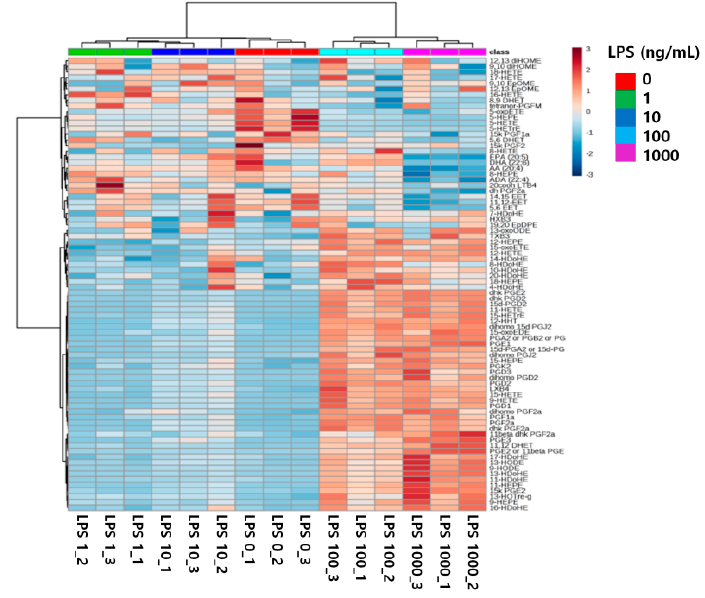
Figure 5. Principal component analysis (PCA) score plot of RAW264.7 cells treated with 0, 1, 10, 100, and 1000 ng/mL LPS.